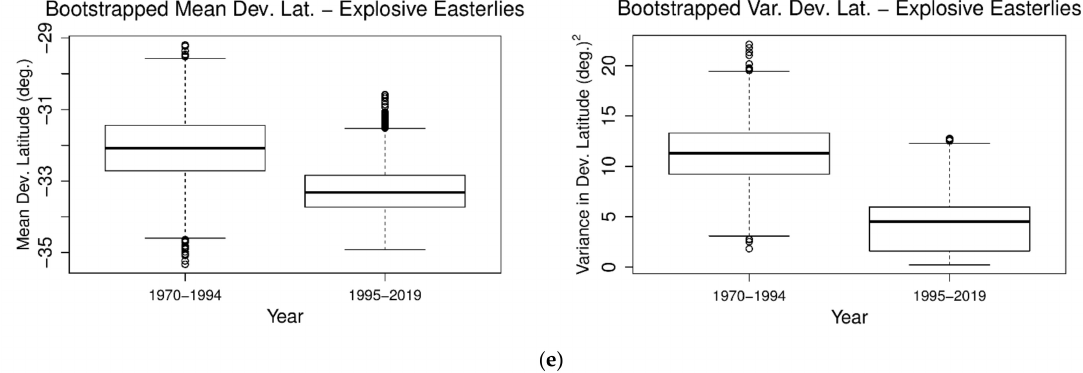
Figure 4. Box and whiskers plots of bootstrapped latitude and longitude ECL categories of mean ( left panel ) and variance ( right panel ) for the periods April–September 1970–1994 and 1995–2019, ( a ) Total Dev. days Easterlies-latitude, ( b ) Total Dev. days Easterlies-longitude, ( c ) Total Dev. days Explosives–latitude, ( d ) Total Dev. days Explosives–longitude ( e ) Total Dev. days Explosive